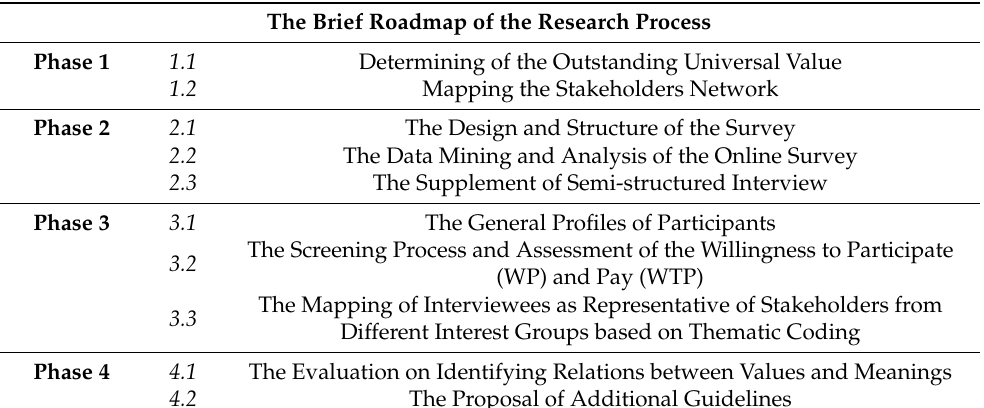
Table 3. The brief roadmap of the research design and process (made by